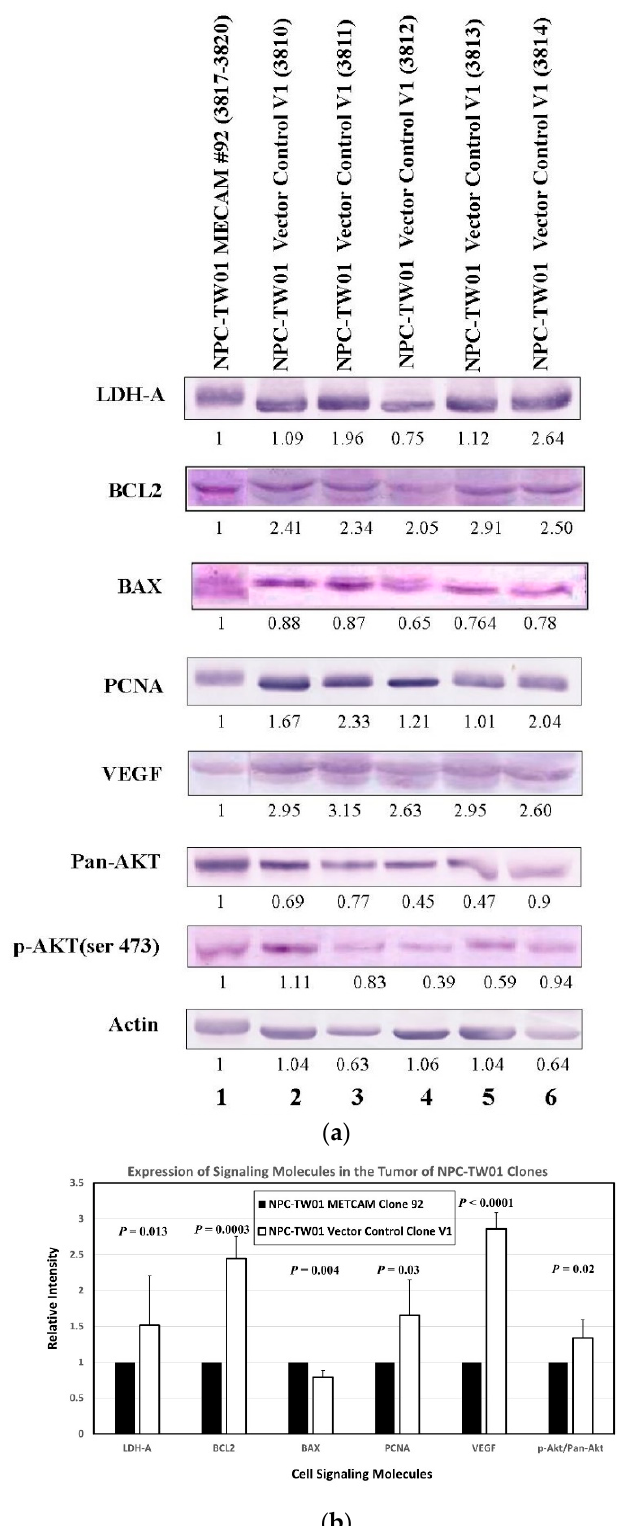
Figure 7. Effects of huMETCAM/MUC18 ′ s over-expression on the expression of key downstream effectors. Tumor lysates were used in the Western blot analysis by using various antibodies, as described in the Section 4. ( a ) The Western blot results of the levels of the various key parameters, such as LDH-A, Bcl2, Bax, PCNA, VEGF, pan-AKT, and phospho-AKT(Ser473), are shown. ( b ) The quantitative results of the above effectors are shown.